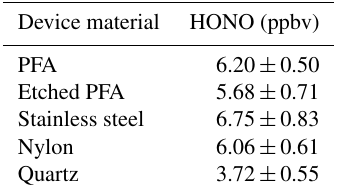
Table 4. Average measured HONO mixing ratios (ppbv) using dif- ferent 1/2in. inner diameter tubing. All results are at 40 ◦ C and us- ing same HCl PD (PD-6c). Variability shown is 1 σ from the mean.